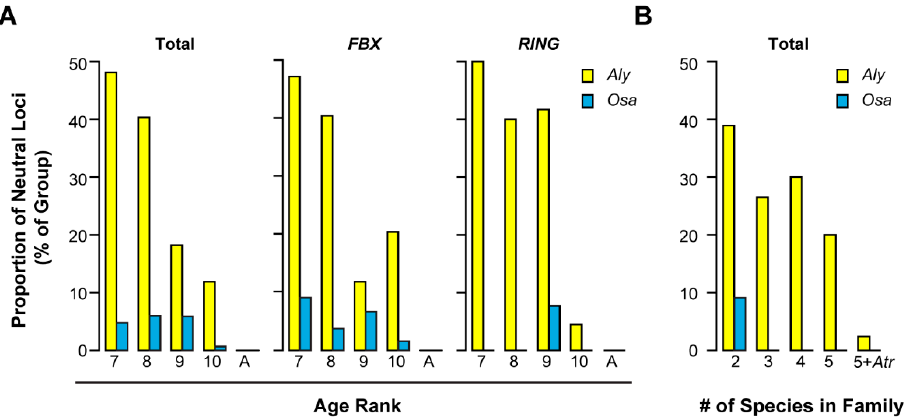
Figure 5. Neutrality test revealed a significant proportion of pseudogenes in Aly – Ath UPS orthologous pairs. ( A ) Age-ranked orthologous Aly – Ath and Osa – Obr pairs were retrieved as in Figure 3B and subjected to neutrality analysis as described in Section 4. The proportion of neutrally evolving loci was plotted against age ranks. ( B ) Non-age-ranked Aly – Ath and Osa – Obr pairs were retrieved based on the number of species present in the same orthologous group from Brassicaceae and Poaceae,